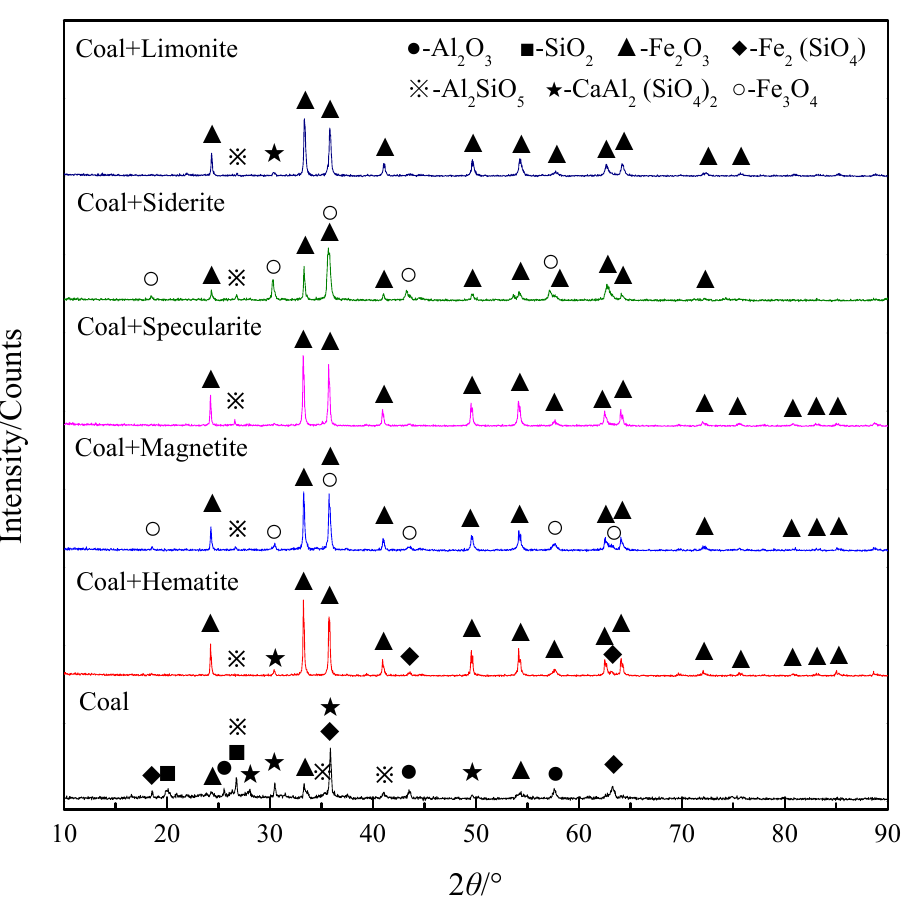
Figure 8. XRD patterns for pulverized coal combustion residues with different iron-containing pure minerals added.